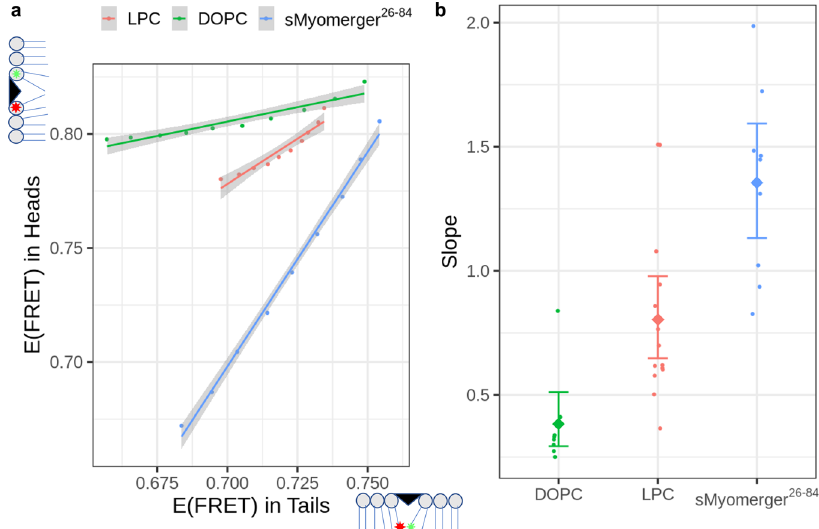
Fig. 1 Effects of insertion of different molecules into lipid bilayer on ef fi ciency of FRET between probes located in lipid headgroup and between probes in lipid hydrocarbon tail regions. a Increasing bulk concentrations of either dioleoyl phosphatidylcholine, DOPC (from 1 µ M to 10 µ M), or lysophosphatidylcholine, LPC (from 10 µ M to 100 µ M) or sMyomerger 26-84 (from 50 nM to 0.5 µ M) were added to 2.5 µ M liposomes containing fl uorescence resonance energy transfer (FRET) pair with both probes located in the lipid headgroup region or with both probes located in the lipid hydrocarbon tail region. Dependence of FRET ef fi ciency characterized as change in quantum ef fi ciency of donor emission due to the presence of acceptors (see Methods section) for probes in headgroup region E(FRET) in Heads vs E(FRET) in Tails for probes in hydrocarbon tails from a representative experiment is shown. For all three reagents and for probes both in the headgroup region and in hydrocarbon tails, E(FRET) monotonously decreased as the bulk concentration of the reagent increased. Individual points correspond to a single bulk concentration of the added molecules, the line shows linear fi t of the data and error bands are centered on the linear fi t values and show 0.95 con fi dence interval of the linear regression. b Slopes of the E(FRET) in Heads vs E(FFET) in Tails are different for DOPC, LPC, and sMyomerger 26-84 with DOPC < LPC < sMyomerger 26-84 . Individual dot points represent a slope estimate obtained as shown in a from an independent experiment ( n = 14, 9, and 8 for LPC, sMyomerger 26-84 , and DOPC, respectively), diamond points and error bars represent slope means with 95% con fi dence